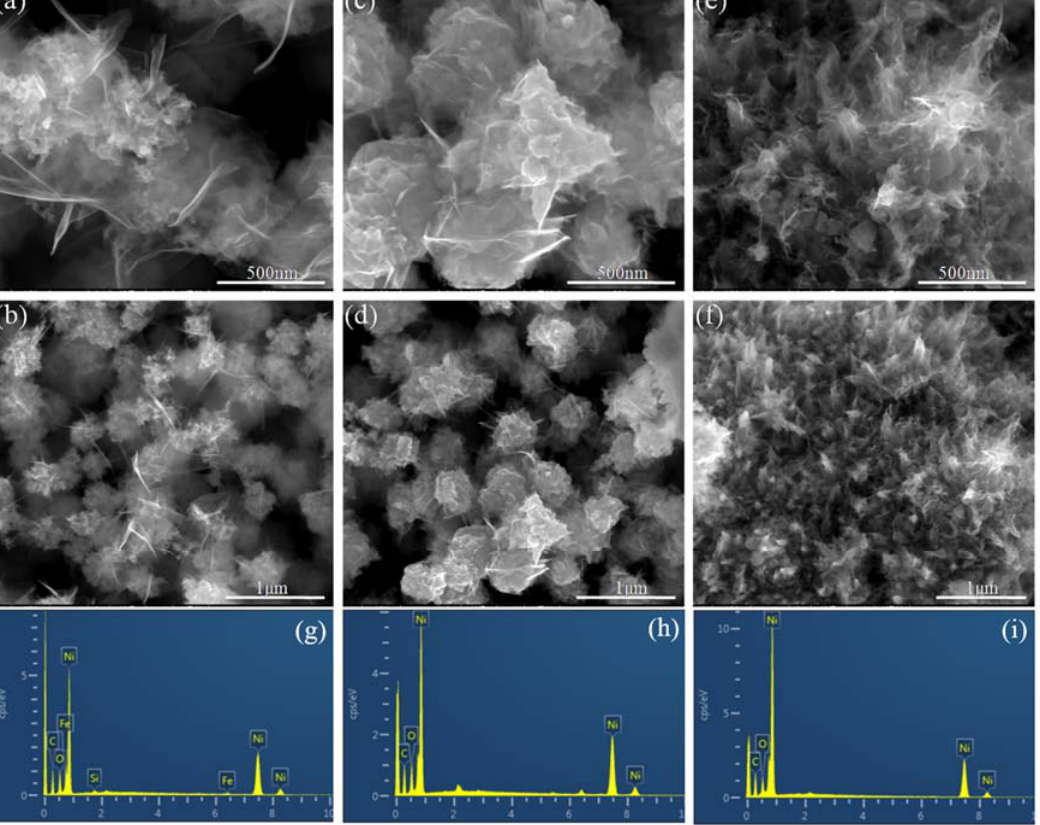
Figure 3. SEM images of the nanoporous Ni obtained with different electroless plating times at 35 °C: ( a , b ) 3 times; ( c , d ) 6 times and ( e , f ) 9 times. EDS spectrums for nanoporous Ni: ( g ) 3 times; ( h ) 6 times and ( i ) 9 times.